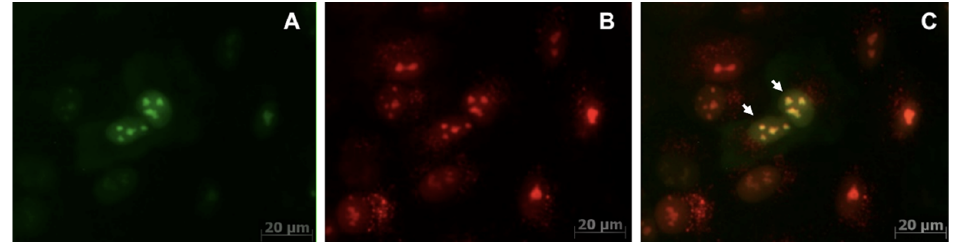
Figure 2. Fluorescence microscopy of A549 cells expressing Tet-On-driven St